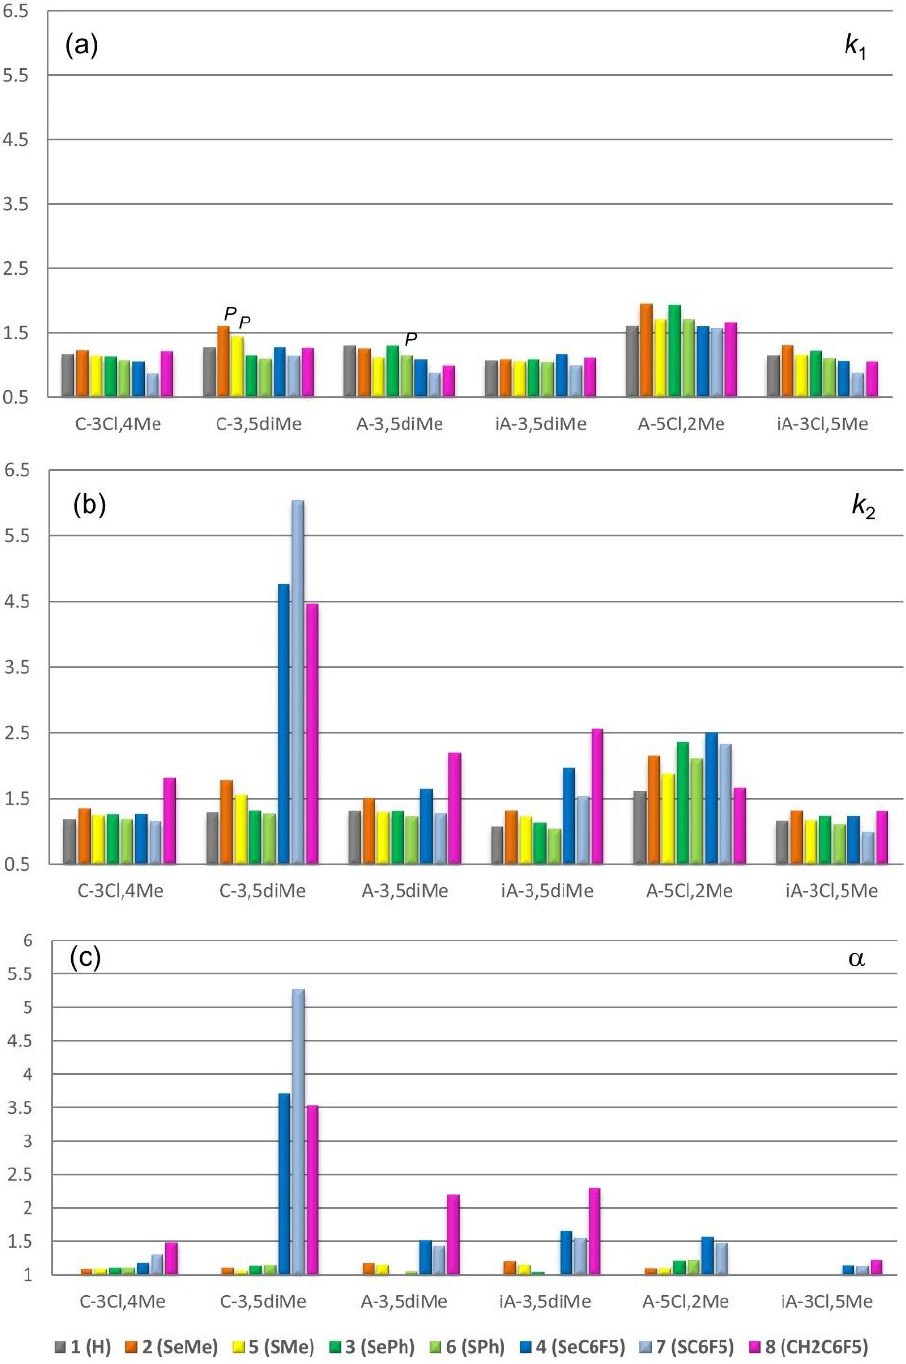
Figure 5. Retention of first ( a ) and second ( b ) eluting enantiomers and selectivity factors ( c ) of the enantioseparations of compounds 2 – 8 on seven polysaccharide-based CSPs. Compound 1 is used as a reference substance.